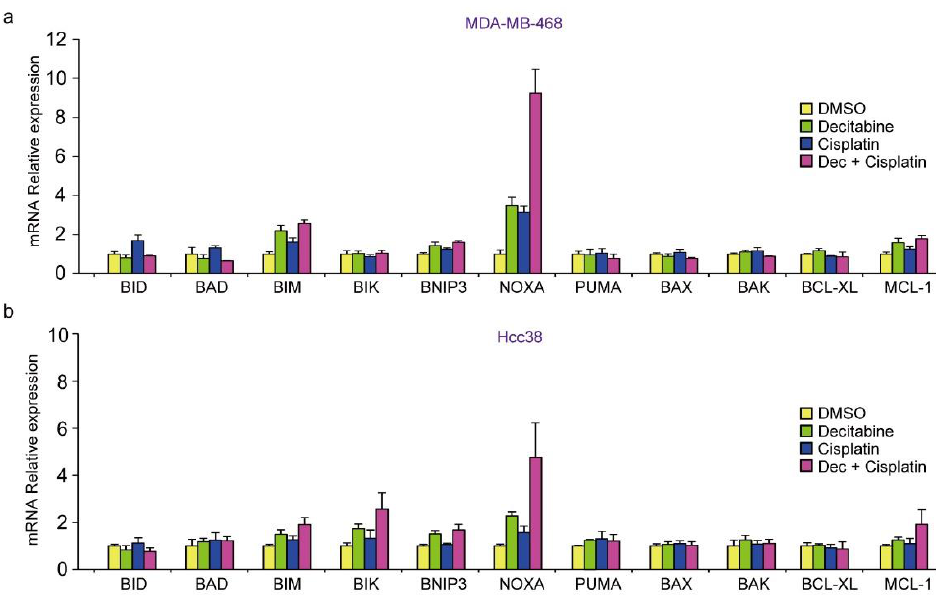
Figure 7. Decitabine enhances the cytotoxic effect of DNA-damaging agents in TNBC cells. ( a ) Each TNBC cell line was treated with vehicle DMSO (1 μg /mL), decitabine (500 nM), and/or cisplatin (20 μM) . After treatment for 72 h, cell proliferation was measured by CCK-8 analysis. ( b ) Each cell line was treated with DMSO (1 μg /mL), decitabine (500 nM), and/or cisplatin (20 μM) . After treatment for 7 days, relative colony numbers were quantified by microplate reader analysis of crystal violet – stained cells. ( c ) Each cell line was treated with DMSO (1 μg /mL), decitabine (500 nM), and/or dox- orubicin (1 μg /mL). After treatment for 7 days, relative colony numbers were quantified by micro- plate reader analysis of crystal violet-stained cells. ( d ) Each TNBC cell line was treated with DMSO (1 μg /mL), decitabine (500 nM), and/or paclitaxel (20 nM). After treatment for 72 h, cell proliferation was measured by CCK-8 analysis. Error bars indicate SD ( n = 3). Data are expressed as the mean ± SD of triplicate experiments. *, p < 0.05; **, p < 0.01.